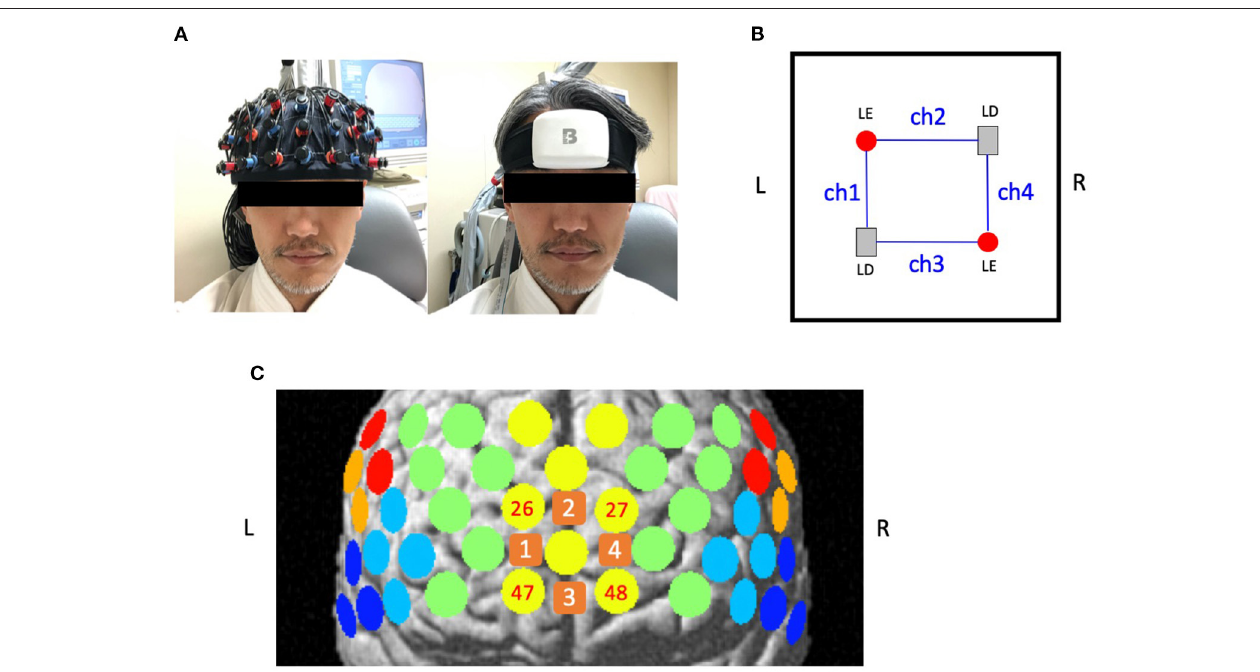
FIGURE 1 | Location of channels for 52-channel near-infrared spectroscopy (52ch-NIRS) and compact NIRS (cNIRS). (A) The probe settings for 52ch-NIRS (left) and cNIRS (right). 52ch-NIRS covers broad regions from bilateral prefrontal to temporal cortices. cNIRS covers only the frontal pole region. (B) Location of 4 channels with 4 optodes (2 light emitters and 2 light detectors) in cNIRS. (C) Measuring positions for 52ch-NIRS and cNIRS are superimposed on the brain surface. Yellow circles represent 52ch-NIRS channels. Orange squares represent cNIRS channels. We created four cNIRS/52ch-NIRS channel pairs (ch1/ch26, ch2/ch27, ch3/ch47, and ch4/ch48). L, left; R, right; LE, light emitter; LD, light